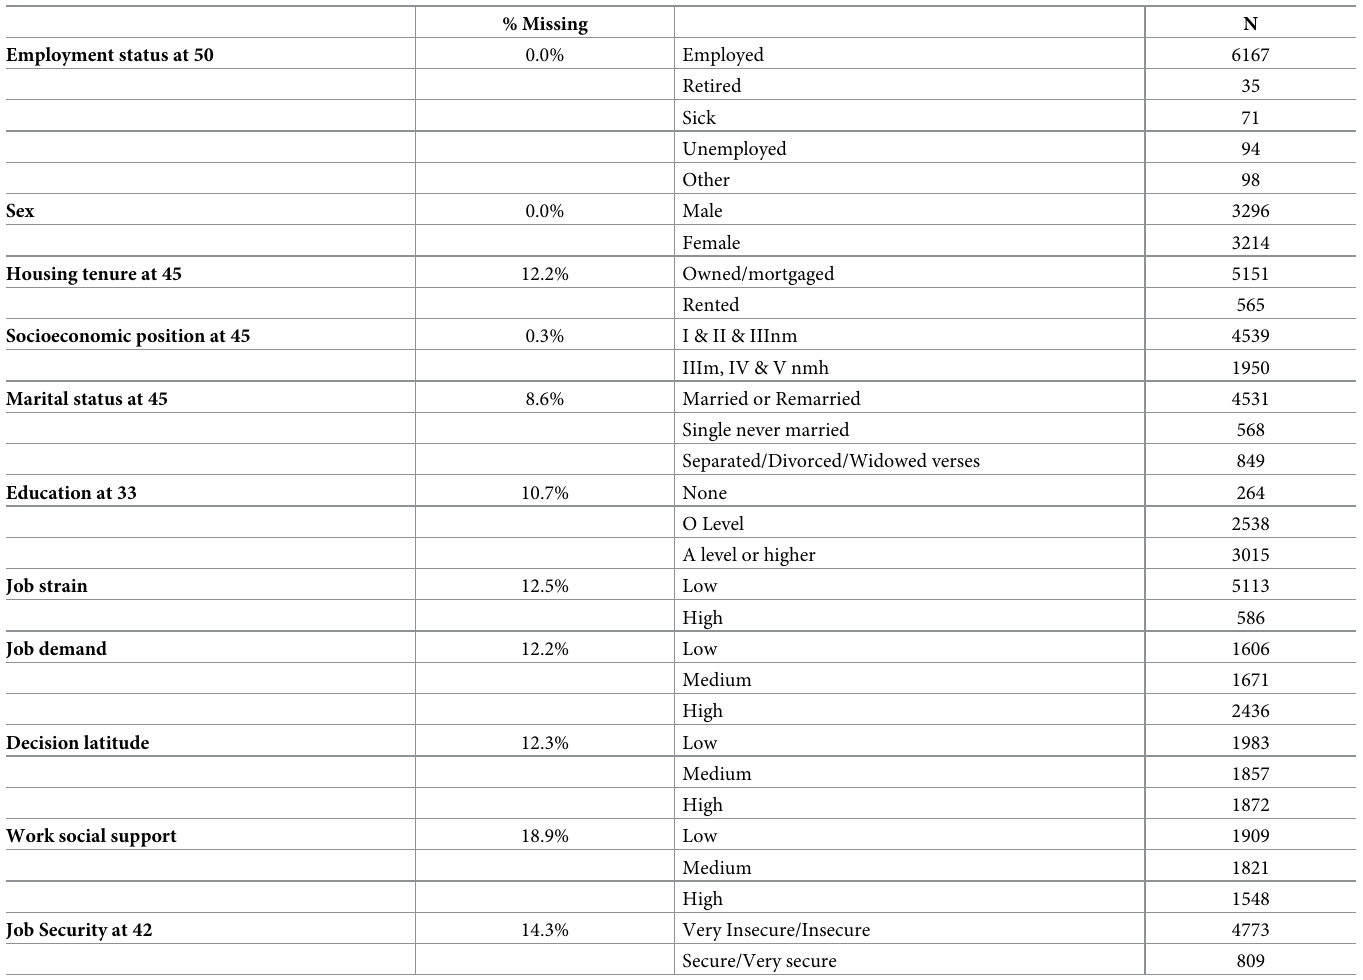
Table 1. Description of working sample at 45 years and percentage of missing